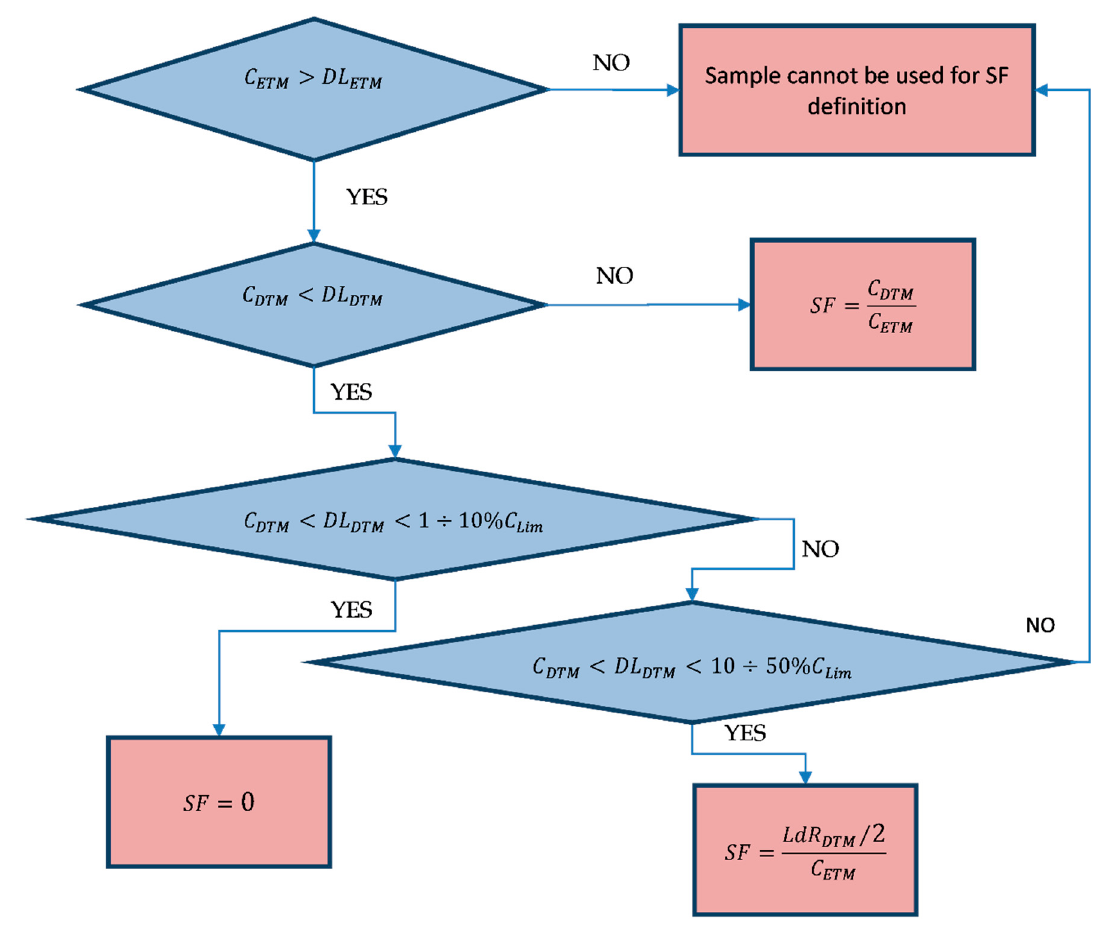
Figure 11. Scaling factors’ decisional flow chart.